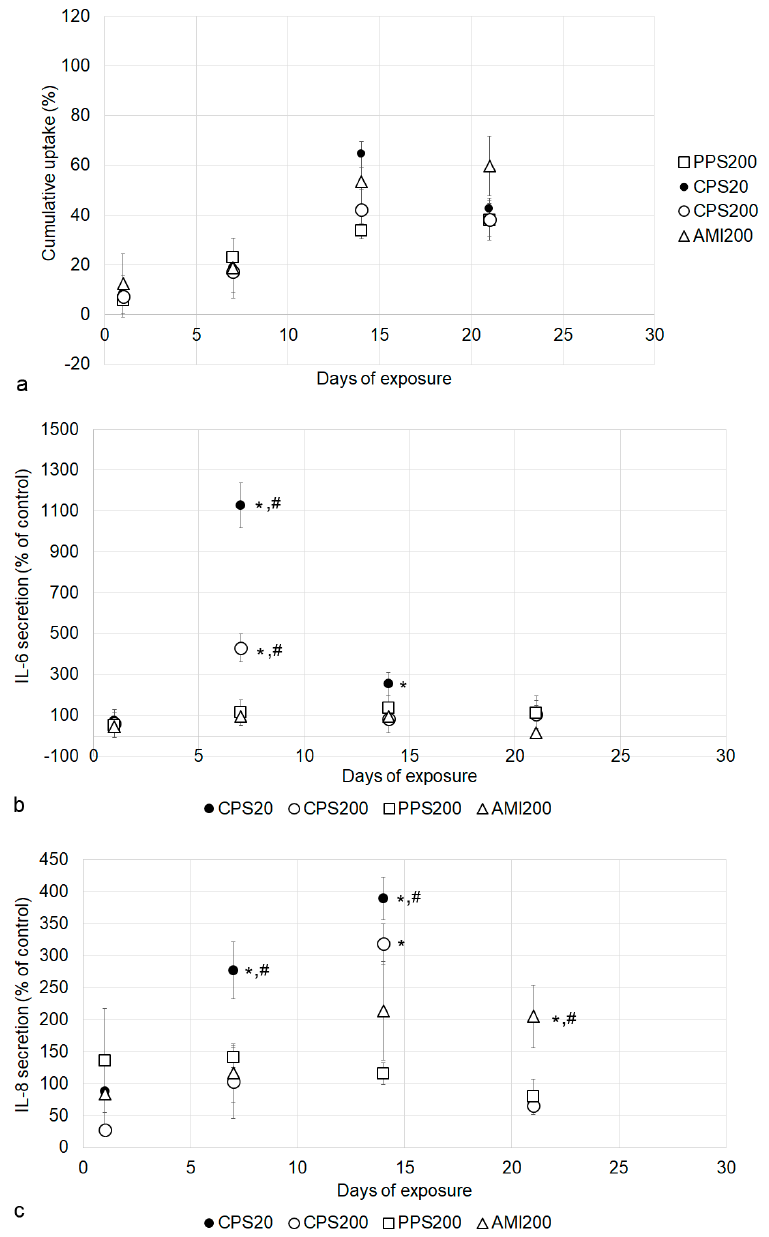
Figure 10. Particle action in A549/THP-1 co-cultures. Cumulative uptake of particles ( a ) and influence on IL-6 ( b ) and IL-8 secretion ( c ) are shown. Significant changes to controls are indicated by asterisks and to other particles by hashtag.